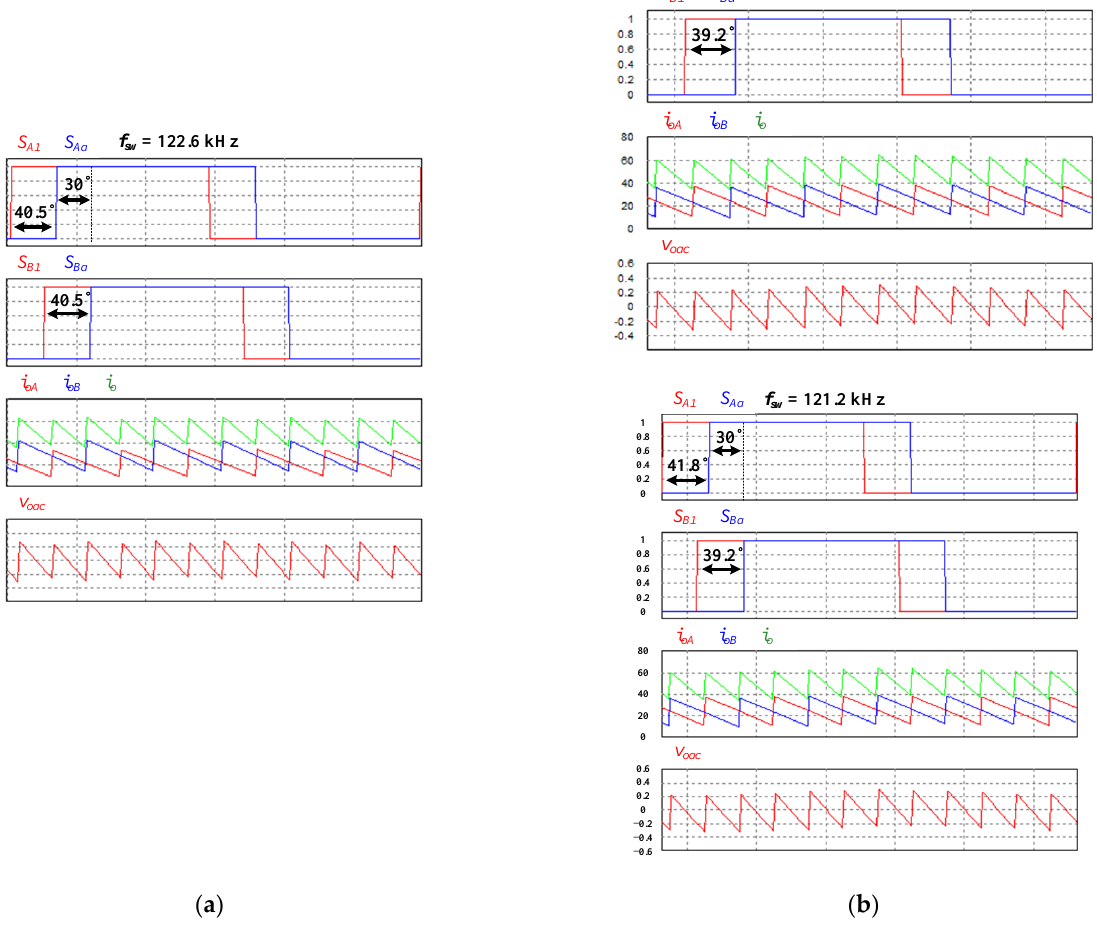
Figure 17. Simulation results of the key waveforms ( a ) without PSM control, ( b ) with PSM control.